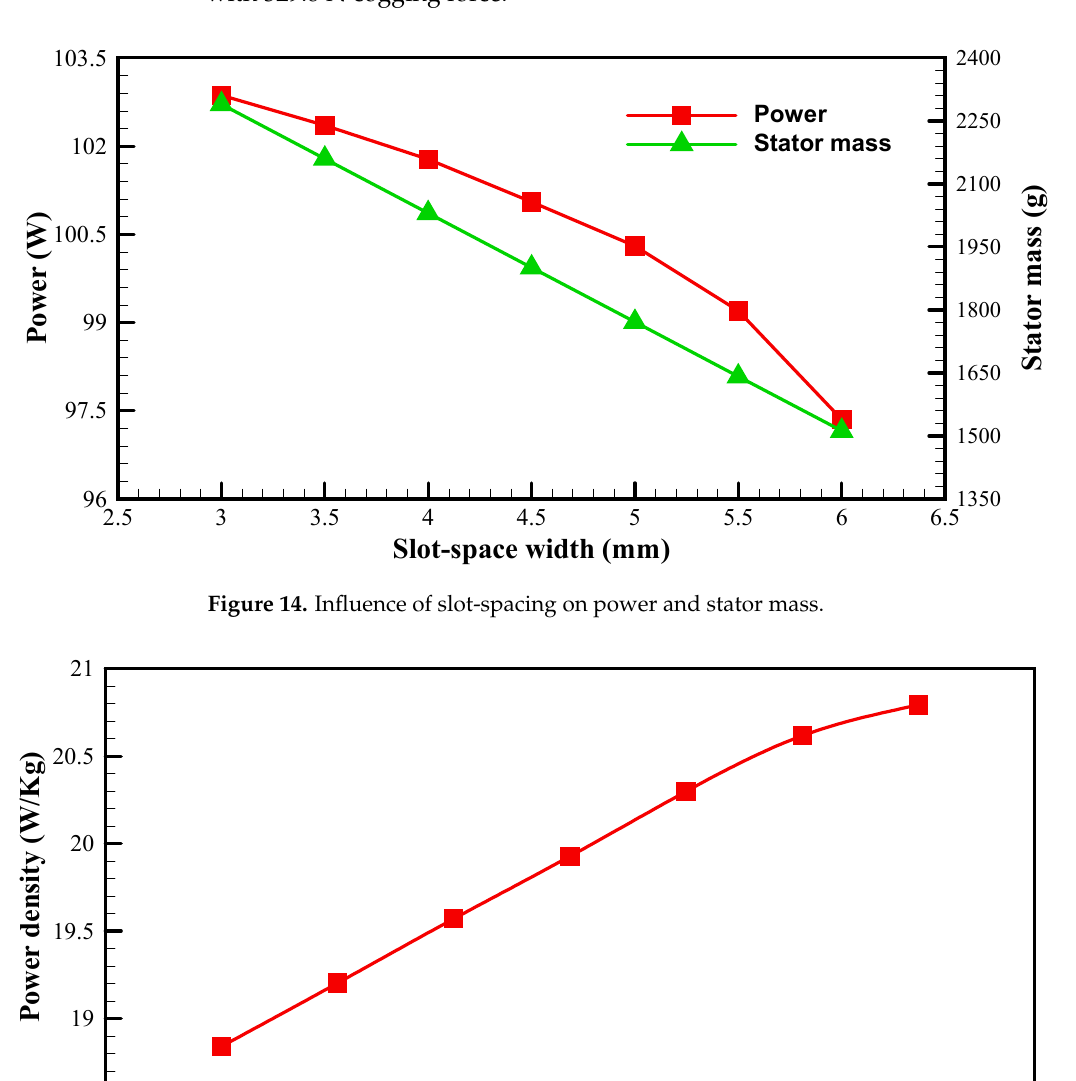
Figure 13. Magnetic flux density for slot spacing of ( a ) 3 mm, ( b ) 4 mm, ( c ) 5 mm, and ( d ) 6 mm.